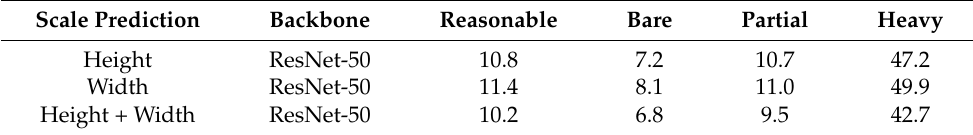
Table 5. Ablation study of different definitions for scale prediction on the Citypersons